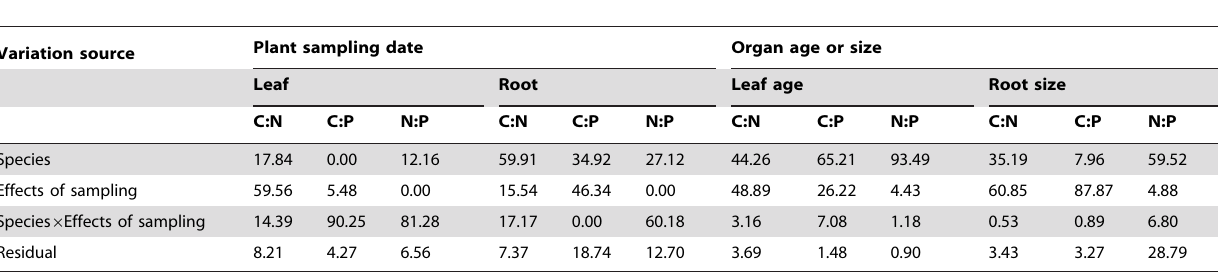
Table 2. Partitioning of total variation (%) of C:N, C:P, N:P into species, effects of sampling (sampling date, leaf age, root size) and residual components in the sand culture